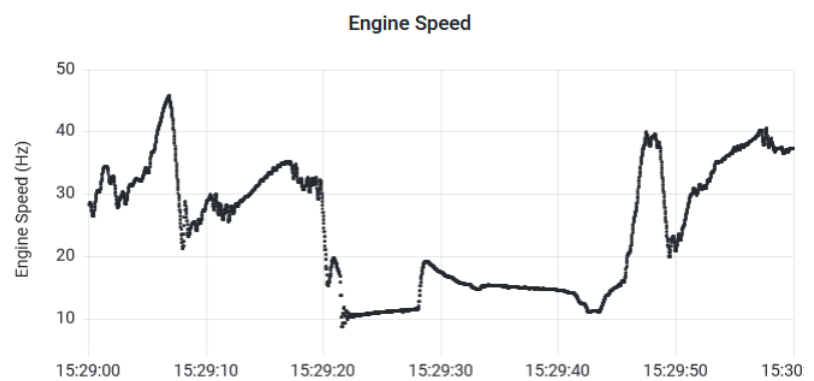
Figure 10. Grafana dashboard vehicle engine